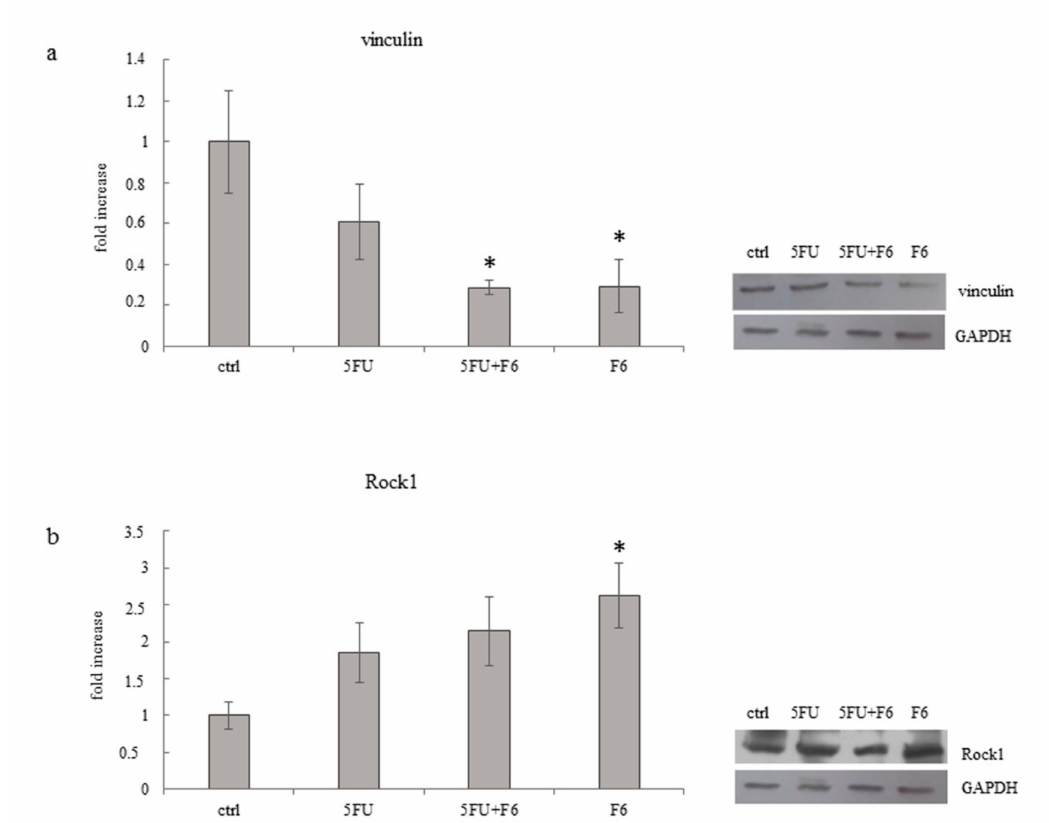
Figure 7. E ff ect of 5FU, 5FU + F6, and F6 on expression of vinculin ( a ) and Rock1 ( b ) in MDA-MB-231 cells. Columns represent densitometric quantification of optical density (OD) of specific protein signal normalized with the OD values of GAPDH served as a loading control and they are expressed as fold increase of control value considered as 1. Each column represents the mean value ± SD of three independent experiments. * p < 0.05 versus ctrl by ANOVA followed by Bonferroni post-test. Representative western blot analysis relating to vinculin and Rock1expression in MDA-MB-231 cells untreated (ctrl) and treated with 5FU, 5FU + F6, and F6 for 24 h. GAPDH was used as loading